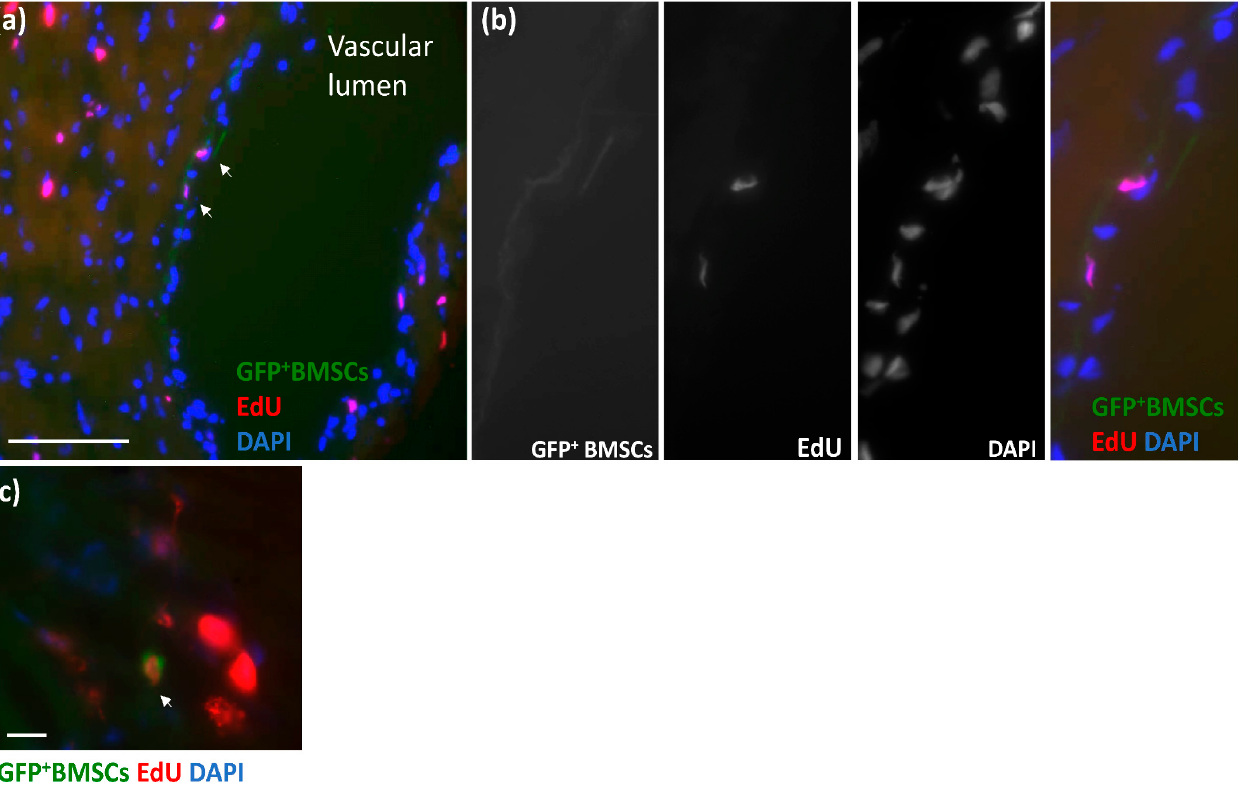
Figure 4. GFP + BMSCs proliferated in the chimeric rat heart during coronary collateral growth induced by repetitive ischemia. ( a ) GFP + BMSCs aligned in the vascular wall of the vascular lumen, co-localizing with 5-ethynyl-2’-deoxyuridine (EdU), which labels the proliferated cells. The scale bar equals 100 µ m. ( b ) High-magnification images of the area with arrows. Green shows GFP + BMSCs. Red shows proliferated cells labeled by EdU. Blue shows nuclei. ( c ) Another image of GFP + BMSCs co-localizing with EdU. The scale bar equals 10 µ m. Green shows GFP + BMSCs. Red shows proliferated cells labeled by EdU. Blue shows nuclei.